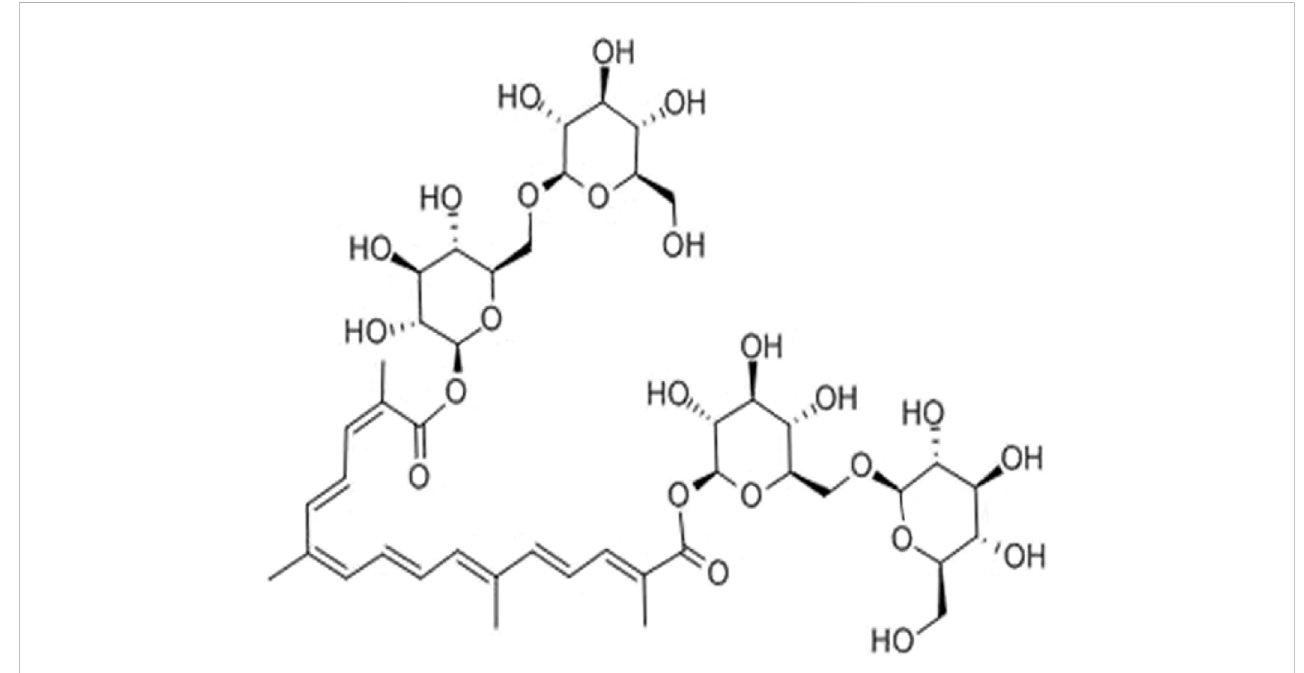
FIGURE 1 The structure of crocin